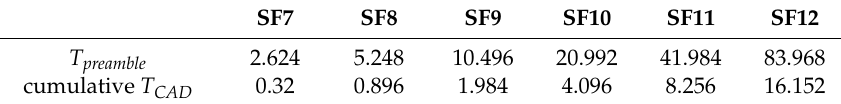
Figure 2. CAD time for ascending and descending selection sequences. Table 1. T PREAMBLE and cumulative T CAD according to SFs. The unit is ms